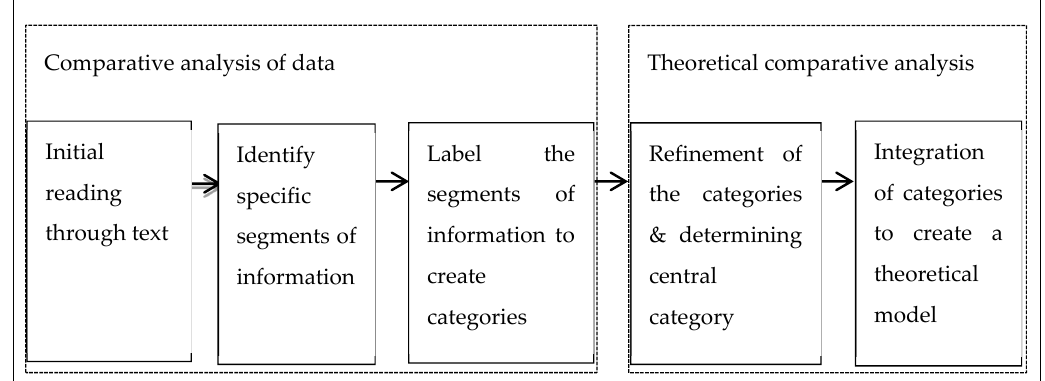
Figure 1. Summary of the process of data analysis and theory building (Mabhala, 2013 [30]).